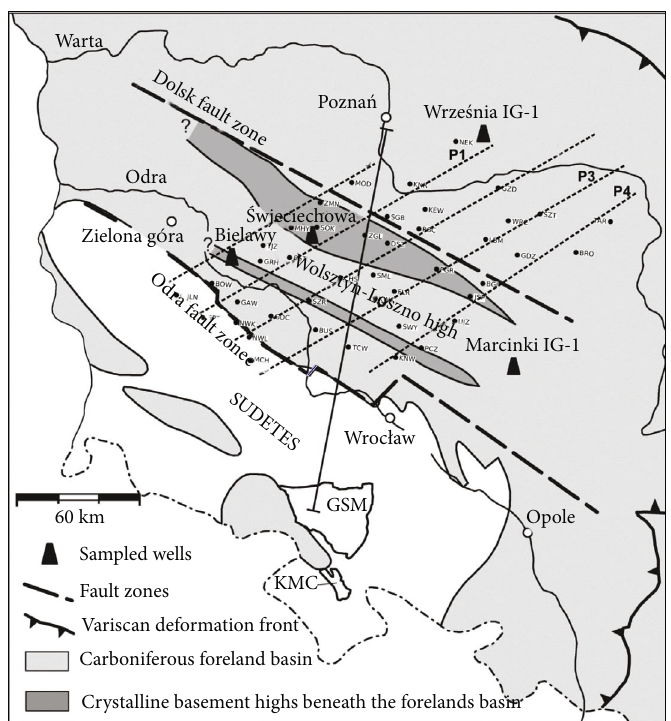
Figure 1: Map of localization of fi ve parallel pro fi les on the background of a geological map. GSM: Góry Sowie Massif; KMC: K ł odzko metamorphic complex; DFZ: Dolsk fault zone [11,